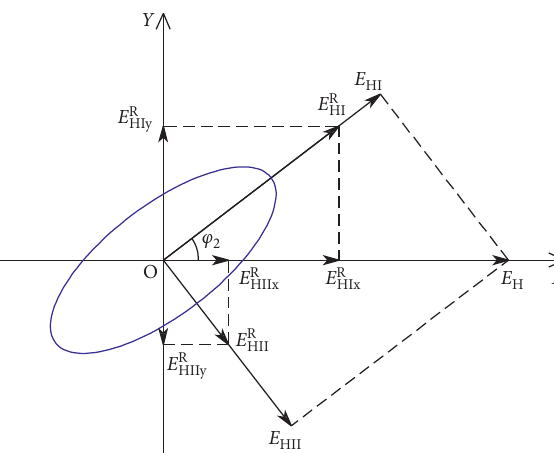
Figure 7: The electric field components of the incident wave and reflection wave in the isotropic and anisotropic interface. Blue ellipse represents the indicatrix ellipse, and its long axis points to the direction of I; wave and short axis points to ; wave. Just incident wave of E H is chosen to demonstrate here, incident wave E V in axis y can be decomposed with the same